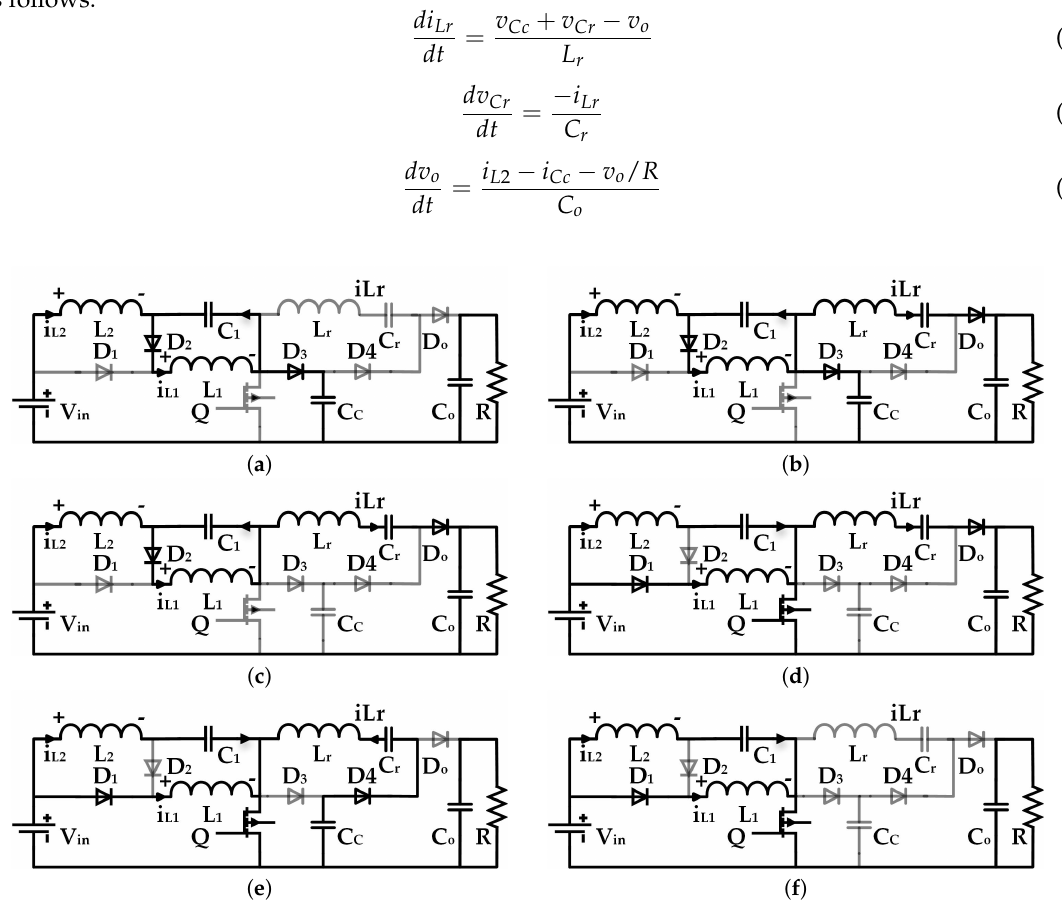
Figure 2. Operation modes: ( a ) mode 1; ( b ) mode 2; ( c ) mode 3; ( d ) mode 4; ( e ) mode 5; ( f ) mode